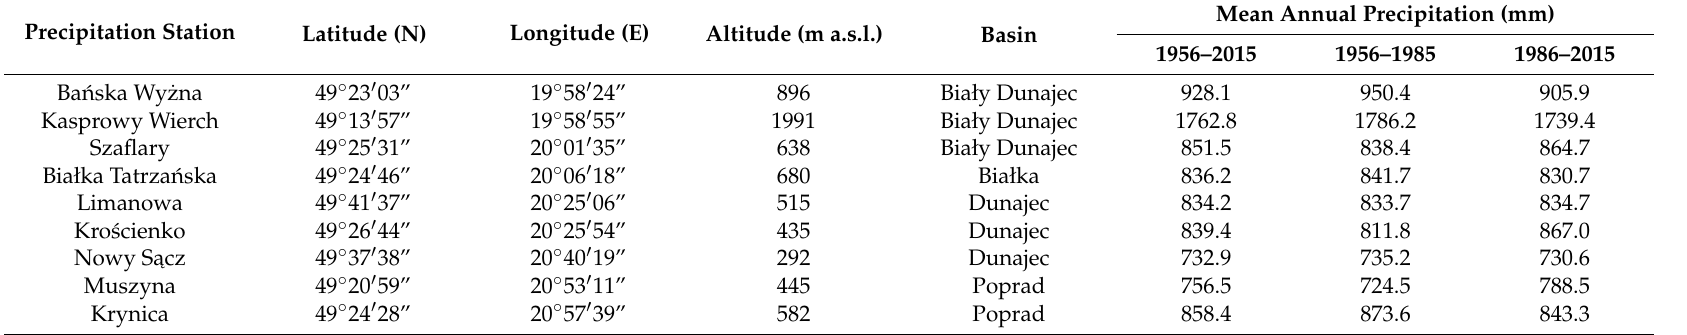
Table 1. Details of precipitation stations used in the study (arranged from west to east).